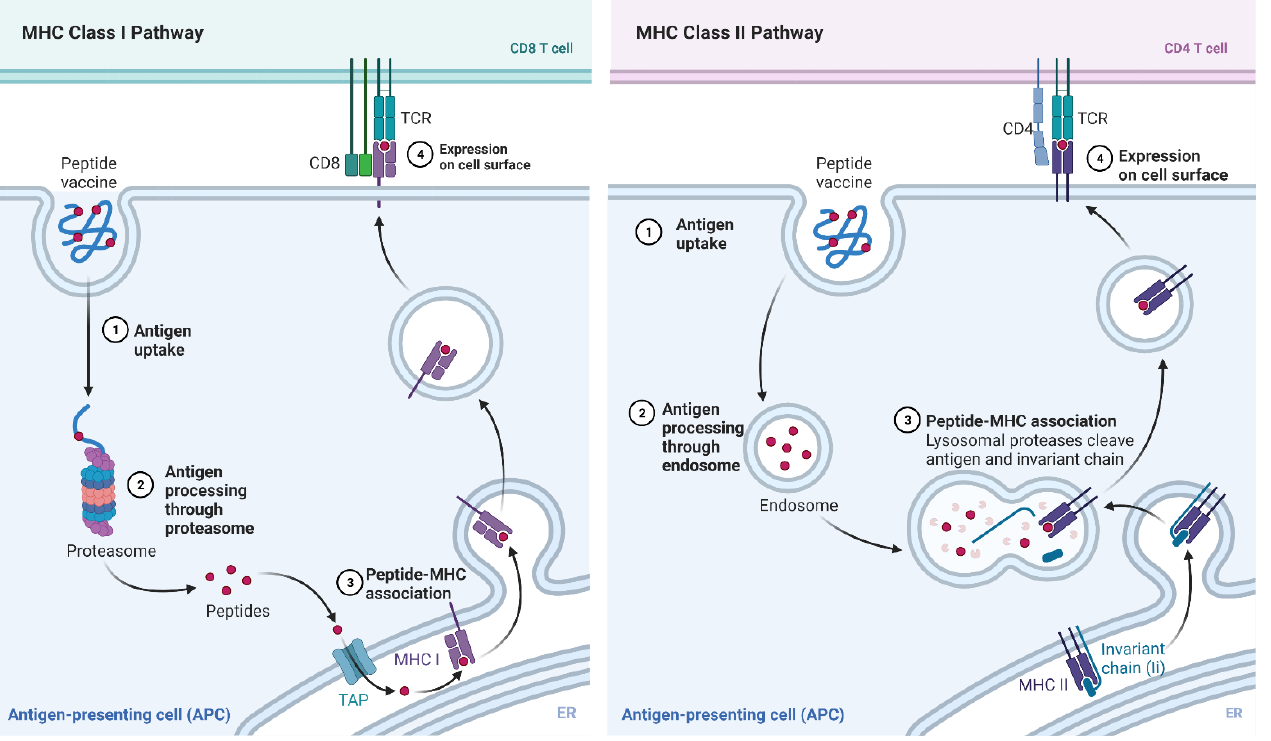
Figure 11. Peptide vaccine mechanism. Peptides will enter the cell and be presented superfi- cially by MHC class I or II molecules. A CD8 T cell response will create an immediate immune response and a CD4 T-cell response will activate lymphocytes as well as create antigens for long-term